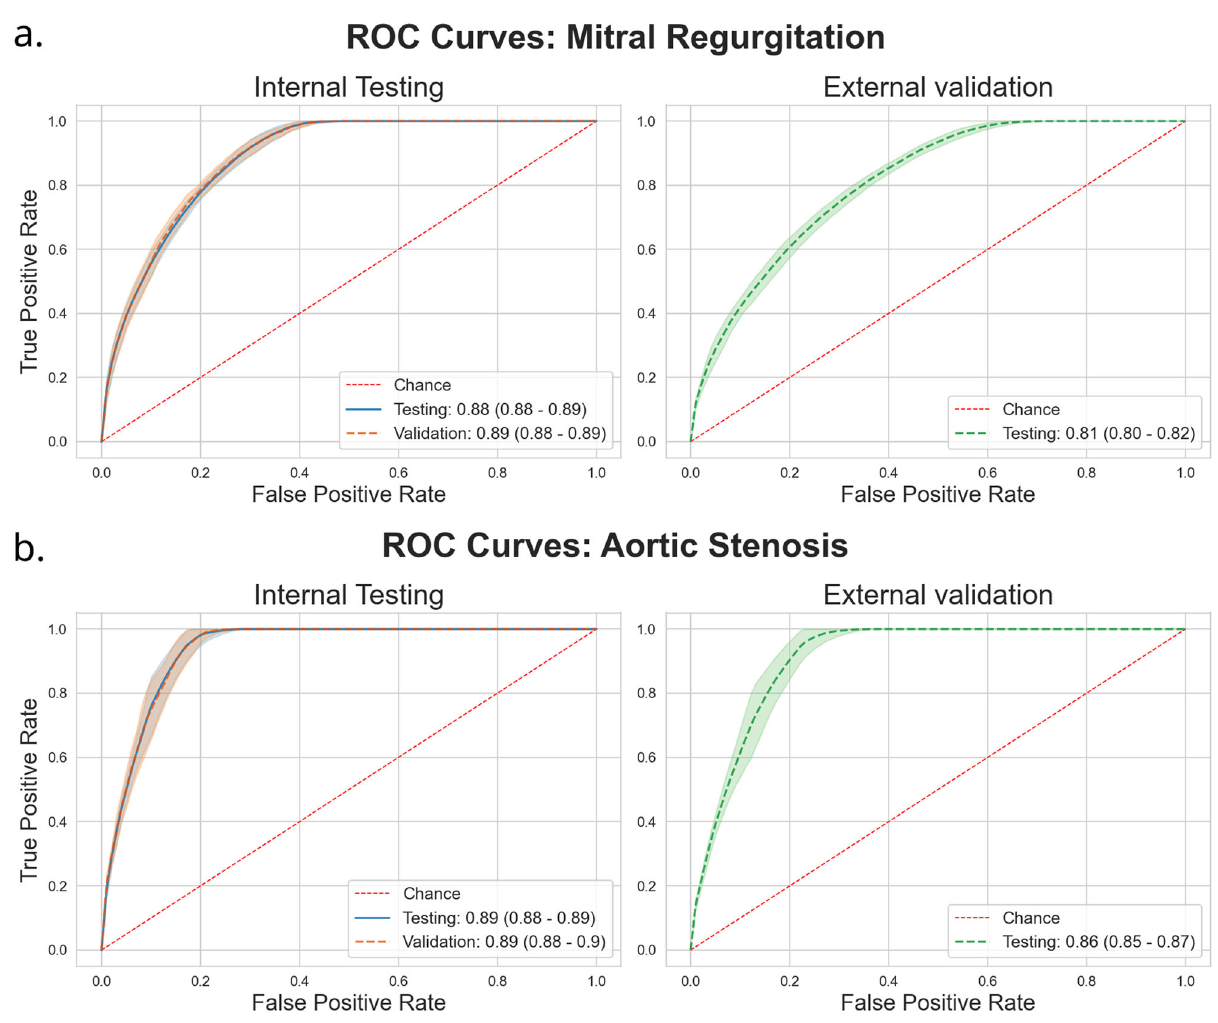
Fig. 2 Receiver Operating Characteristic (ROC) Curves. Panel a Mitral Regurgitation. Panel b Aortic Stenosis. Area Under Curve (95% Con fi dence Interval) with shaded area around curve representing con fi dence interval. Red dashed line represents fl oor of performance as in the case of a hypothetical model making purely random predictions. Overall dataset size: 607,429 Echo-ECG pairs for 123,096 patients for Mitral Regurgitation. 617,338 Echo-ECG pairs for 128,628 patients for Aortic